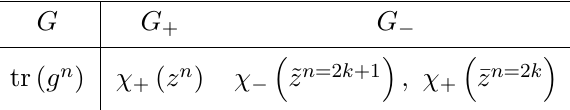
y i = 1 . The variable i =1